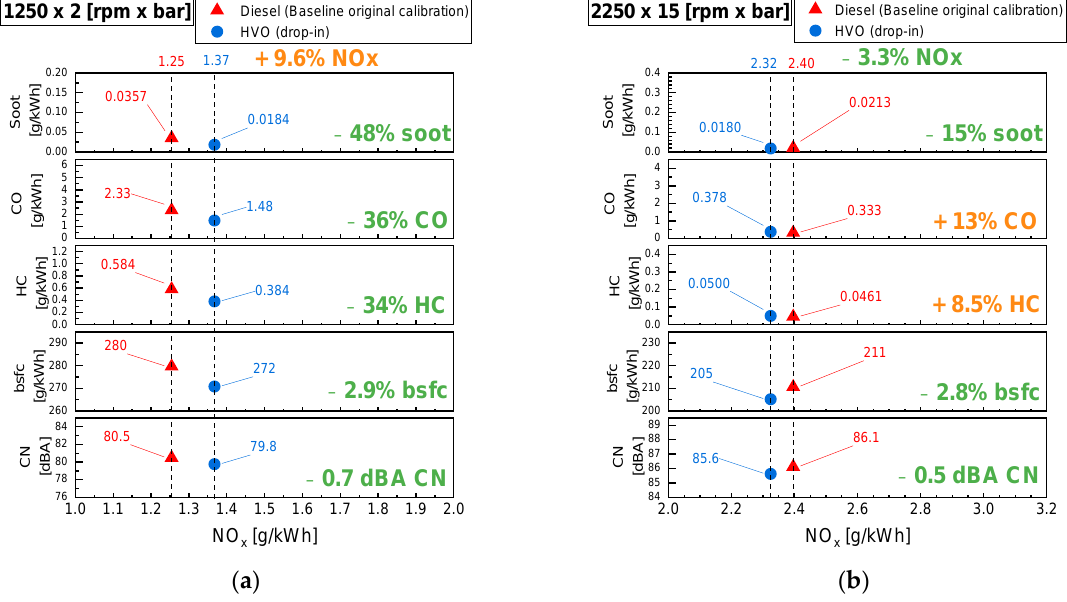
Figure 2. Emissions, fuel consumption and combustion noise for diesel and HVO at 1250 × 2 ( a ) and 2250 × 15 ( b ). Results with the baseline (diesel-oriented) ECU calibration.